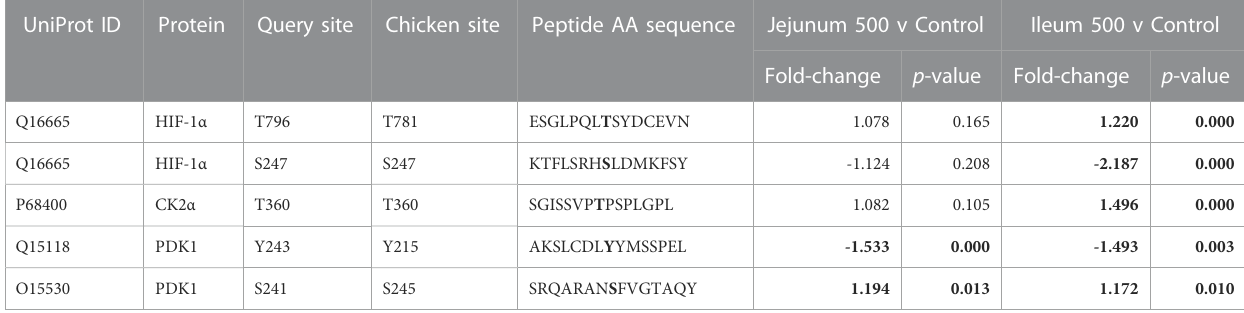
TABLE 4 HIF-1 α and related proteins ’ phosphorylation events. Here, the kinome peptide array results are shown. Jejunum 500 and ileum 500 were compared to their respective control tissues. Phosphorylation events represented in this table show signi fi cant ( p -value < 0.05) for each site in ileum while these sites are not signi fi cantly altered in jejunum. Signi fi cant values are highlighted in bold.